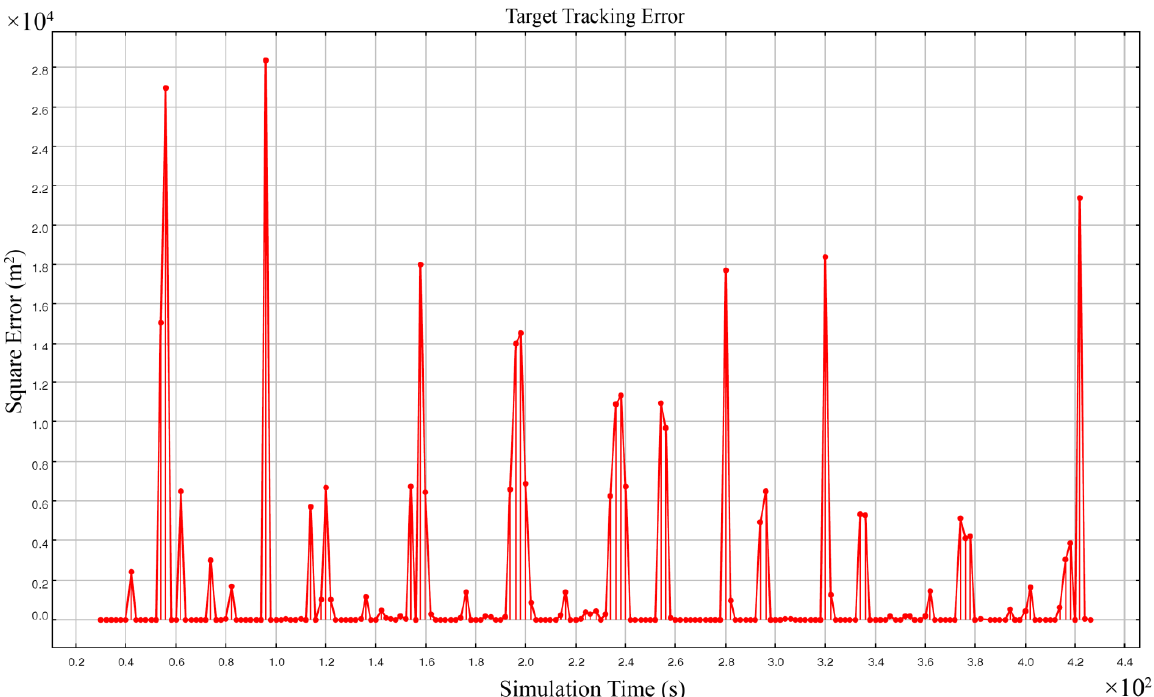
Figure 9. Square error of 3-dimensional acoustic target tracking of FCAL